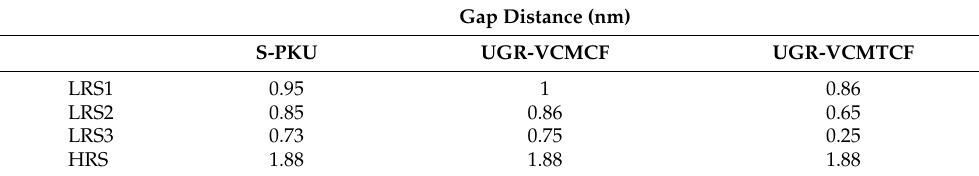
Table 2. Gap distances for simulating the different resistance